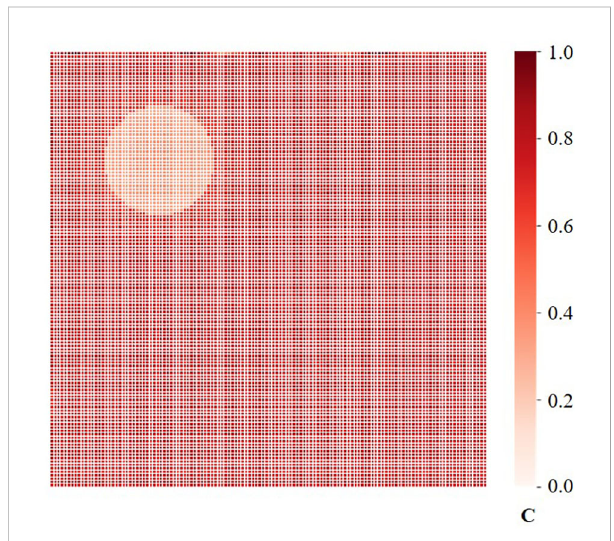
FIGURE 3 Design of the initial concentration fi eld. The size of the concentration fi eld is [0,1]×[0,1], and the concentration value is between 0 and